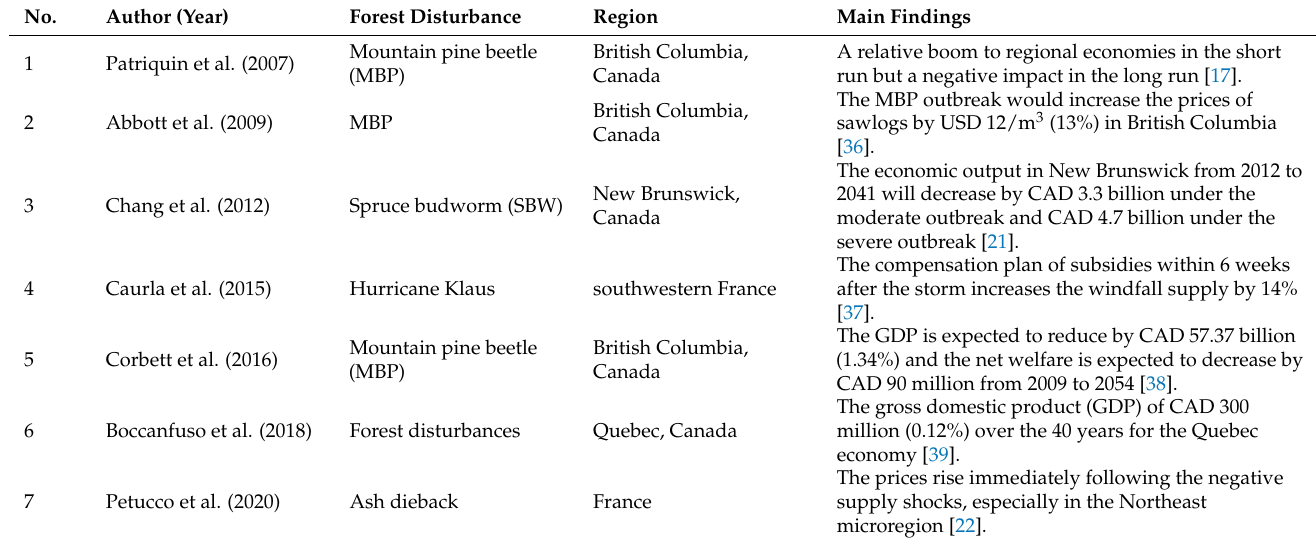
Table 4. Summaries of articles using equilibrium